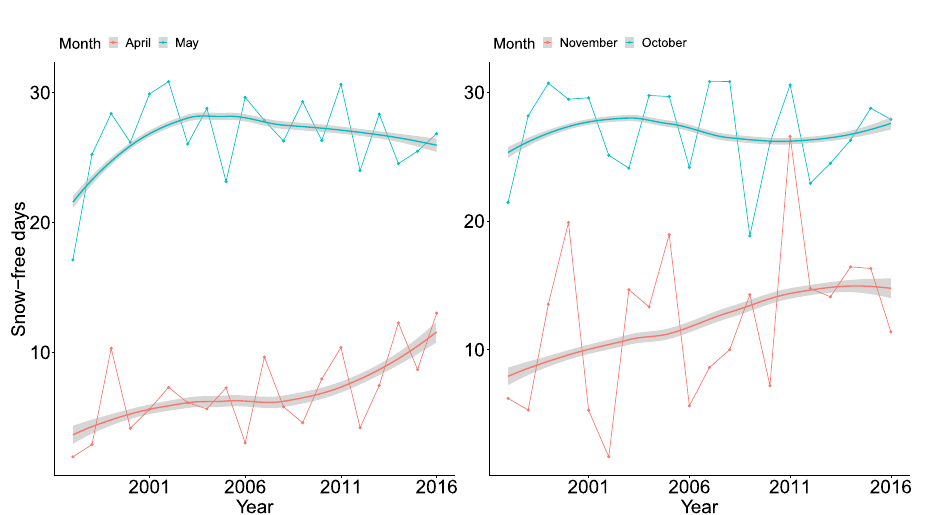
Figure 2. Number of observed willow grouses in the two climatic zones per year. The smoothed trendlines are for illustrative purpose only.